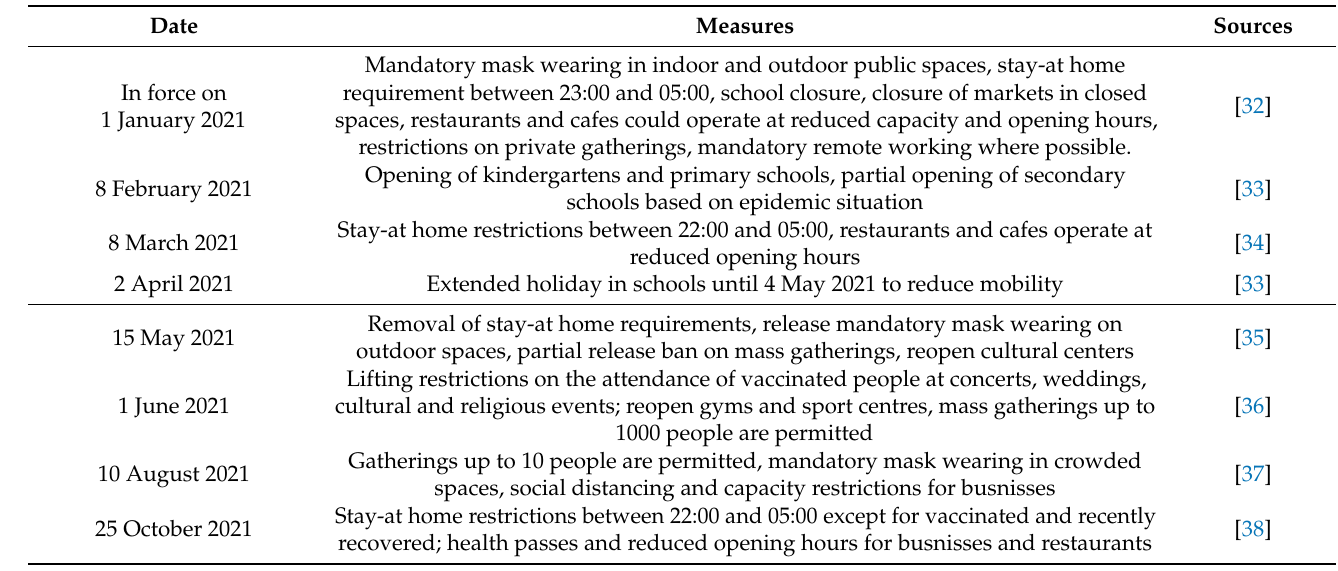
Figure 1. Stringency index values and confirmed COVID-19 cases per million in Romania between 1 January 2021 and 31 December. Source: University of Oxford [27]. Between 15 May and July, restrictions were eased on several occasions (Table 2). The stringency index rose during August, but it remained lower than before, hovering between 50 and 60 for the rest of the year, although the 7-day moving average of the confirmed cases at the peak of the fourth wave on 25 October was 2.66 times that of the third wave. Table 2. Most important non-pharmaceutical measures in Romania between 1 January 2021 and 31 December.